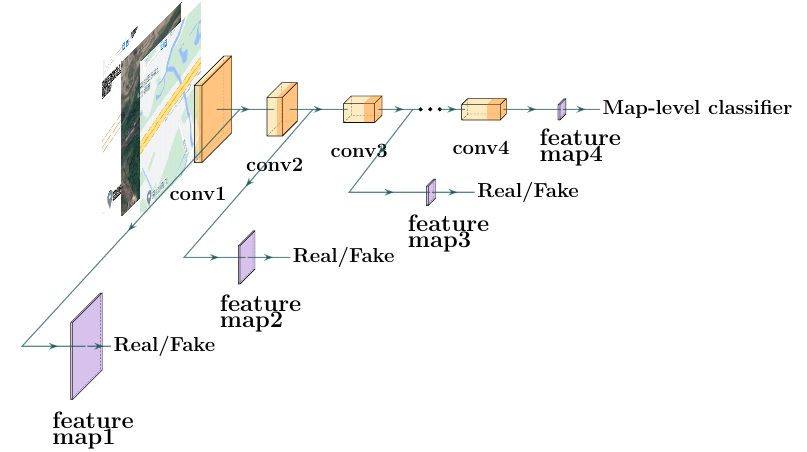
Figure 6. The architecture of each multi-scale